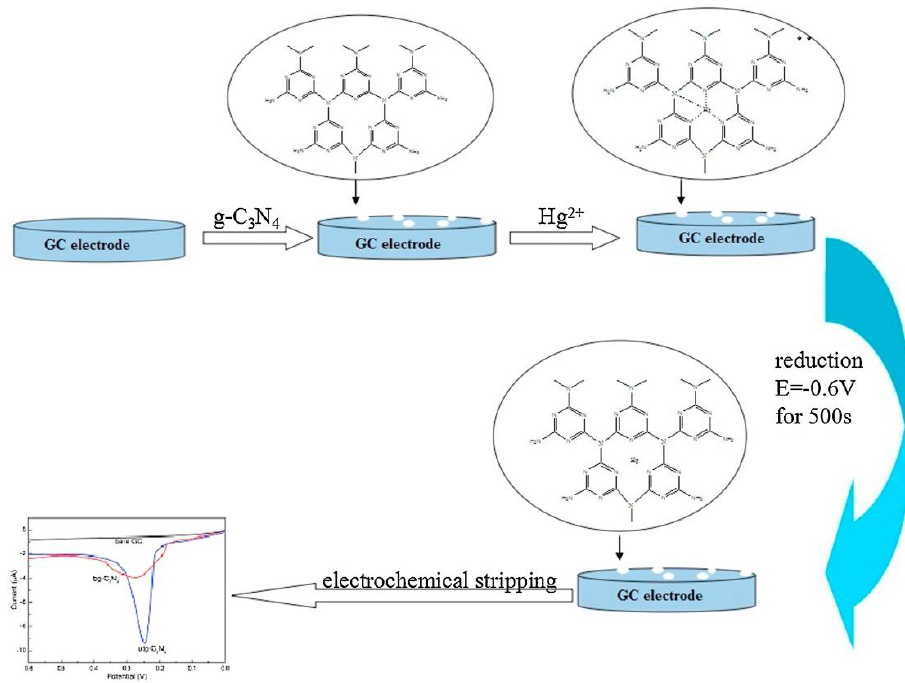
Scheme 2. Illustration of the electrochemical sensing Hg 2+ ions using ultrathin g-C 3 N 4 /GCE electrode (reproduced with